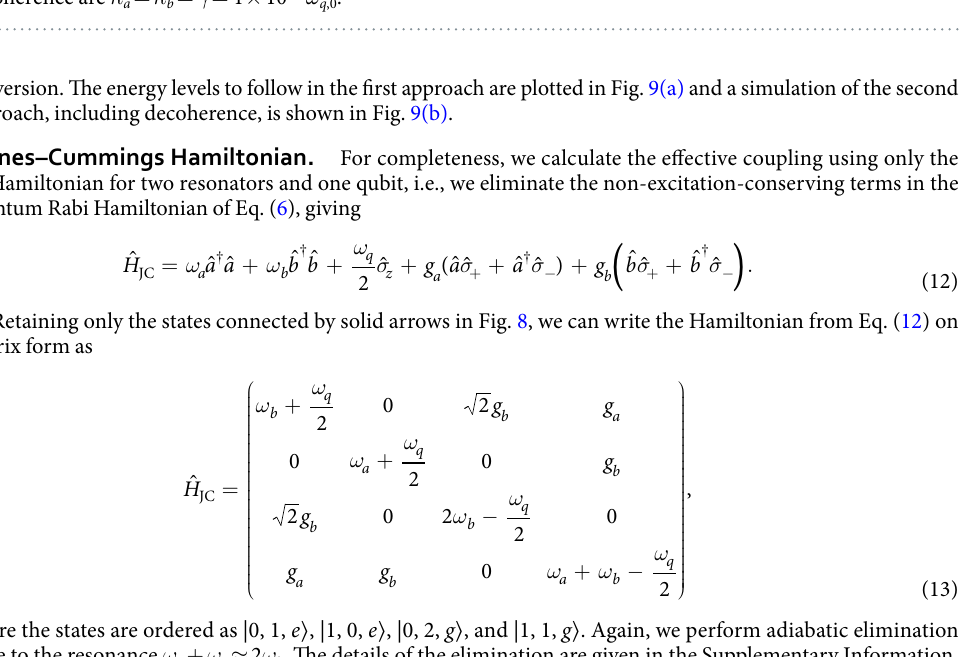
Figure 9. Two-photon frequency conversion via transitions between |1, 0, e 〉 and |0, 2, g 〉 . (a) The energy levels of our system, given in Eq. (6), plotted as a function of the qubit frequency ω q , using the parameters g a = g b = 0.125 ω q ,0 , ω a = 3 ω q ,0 , and ω b = 2 ω q ,0 , where the reference point ω q ,0 is set such that ω a + ω q ,0 = 2 ω b . In the zoom-in, close to the resonance ω a + ω q = 2 ω b , we see the anticrossing between |1, 0, e 〉 and |0, 2, g 〉 with the splitting 2 g eff given by Eq. (11). Up-conversion of a photon pair into a single photon, or down-conversion of a single photon into a photon pair, can be achieved by adiabatically tuning ω q to follow one of the energy levels in the figure from |0, 2, g 〉 to |1, 0, e 〉 , or vice versa. (b) A rapid frequency conversion can be achieved by starting in |1, 0, e 〉 or |0, 2, g 〉 , far from the resonance ω a + ω q = 2 ω b , tuning the qubit frequency (pink solid curve, a smoothed step function as explained in Fig. 3) into resonance for half a Rabi period ( π /2 g eff ) and then tuning it out of resonance again. The figure shows the number of excitations in the two resonators (red solid curve for a , black dashed-dotted curve for b ) and the qubit (blue dashed curve) during such a process, including decoherence in the form of relaxation from the resonators and the qubit. The parameters used for the decoherence are κ a = κ b = γ = 4 × 10 − 5 ω q ,0